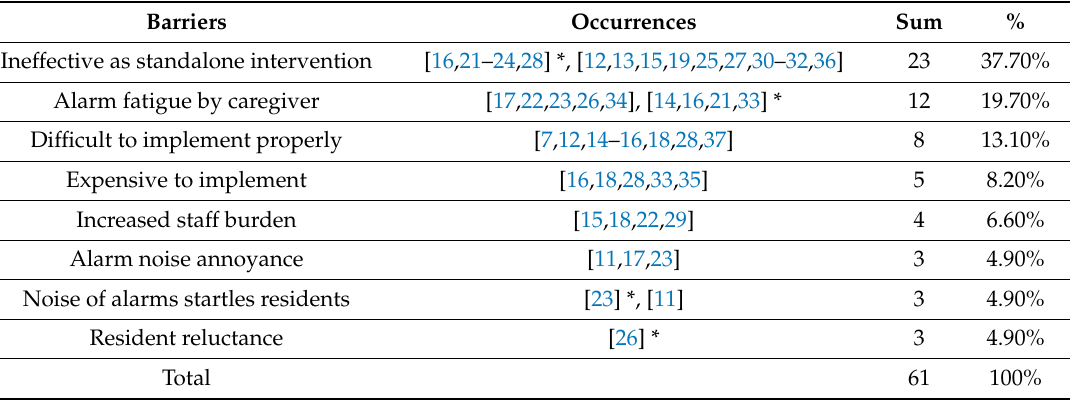
Table 2. Themes associated with alarms and fall